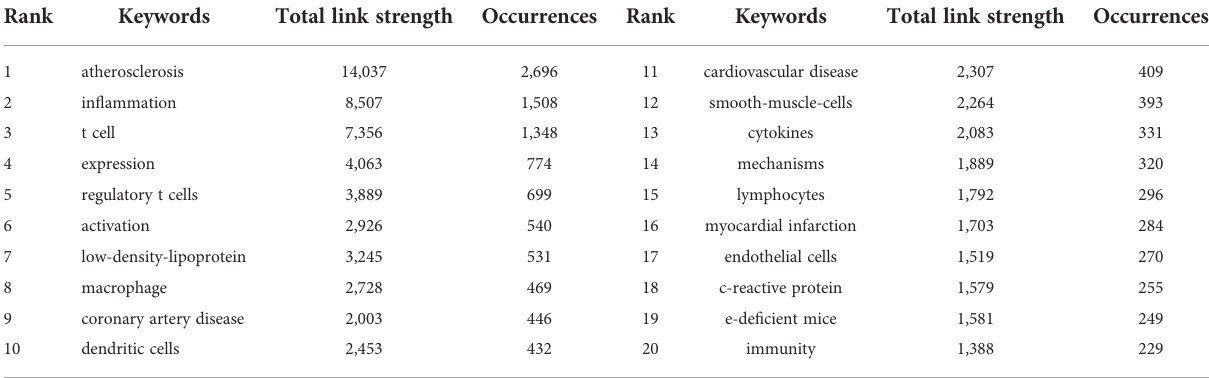
Here includes the automatically calculated total link strength by selected. The keyword co-occurrence network graph (Figure 7A) displays that the thicker the connection between nodes, the higher the frequency of two keywords appearing together. research directions T cell and AS.